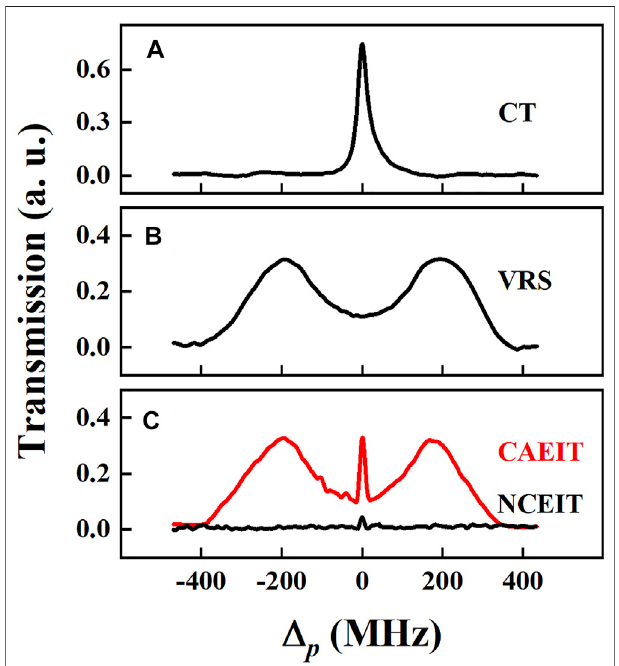
FIGURE 2 | (A) Cavity transmission (CT) as a function of the probe frequency detuning ( Δ p ) from the 87 Rb 5 S 1/2 ( F = 2) – 5 P 3/2 ( F ′ = 3) resonant transition when the vapor cell is placed into the optical ring cavity. (B) VRS without coupling laser. (C) Non-resonant cavity EIT (NCEIT) (black) and CAEIT (red) under consistent experimental parameters. The curve lines of VRS, CAEIT, and NCEIT are all expanded by 12 times to give a clear visual contrast.